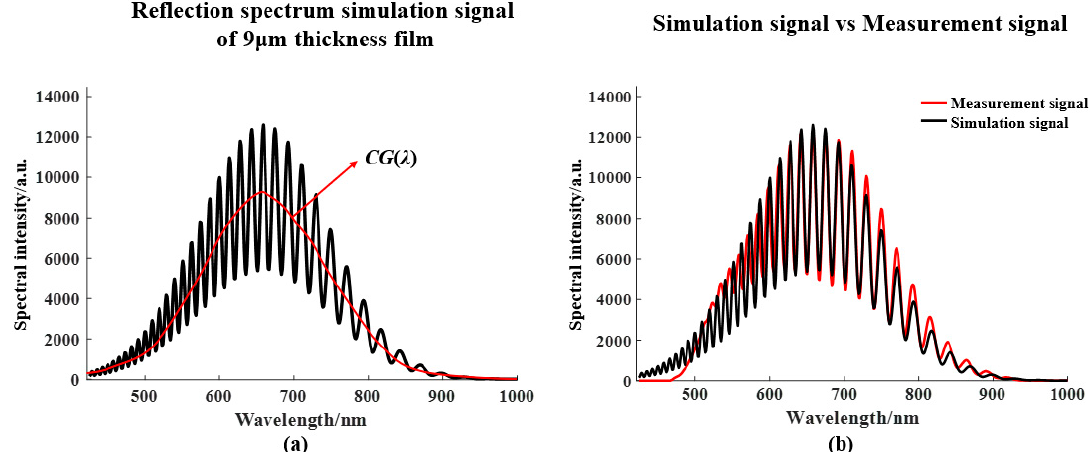
Figure 5. The 9 µ m thickness film interference simulation diagram. ( a ) Simulation diagram of reflection spectrum under Gaussian light source; ( b ) Comparison of reflection spectrum simulation and measurement signal.